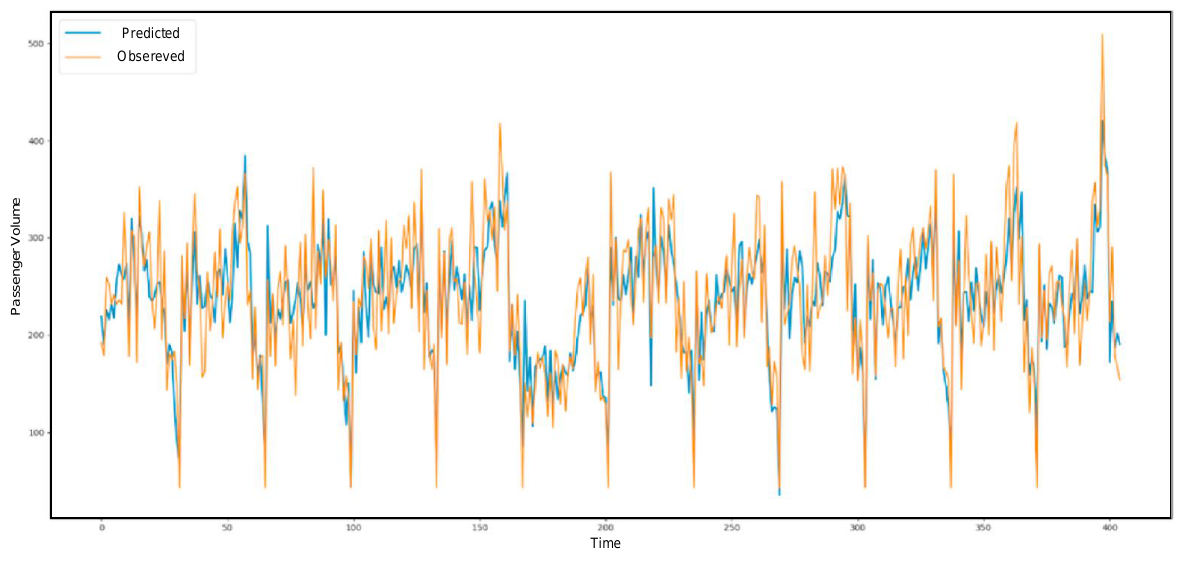
Figure 14. The 30-min prediction result.